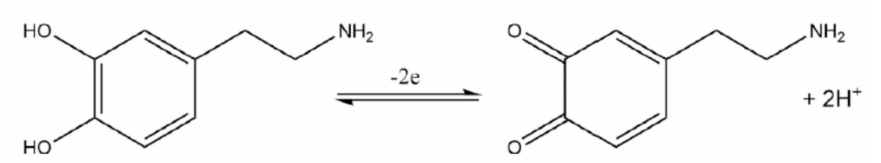
Figure 2. Electrochemical oxidation of dopamine to dopamine quinone in a 2-electron oxidation when a potential is applied to the